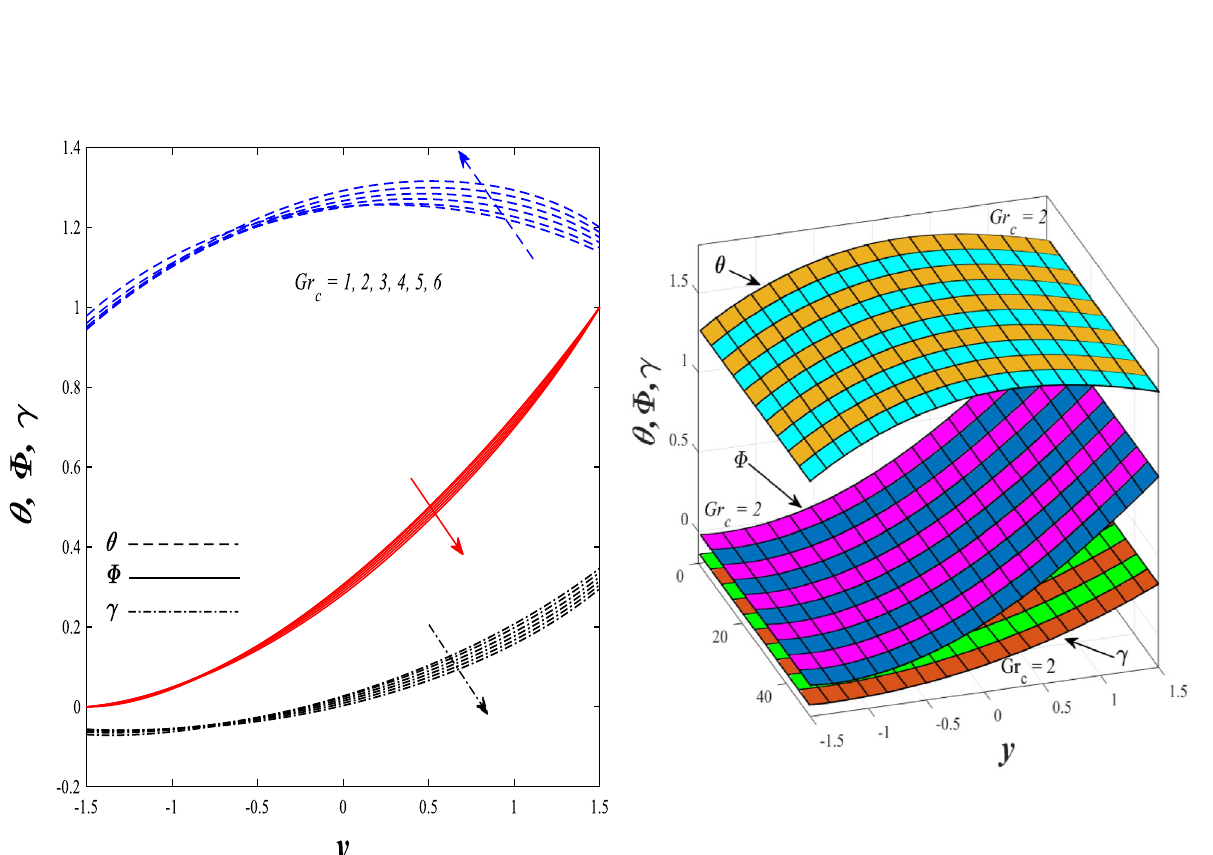
Figure 19. Effect of solutal Grashof number Gr c on the distributions of both temperature, solutal concentration and nanoparticles volume fraction 2D and